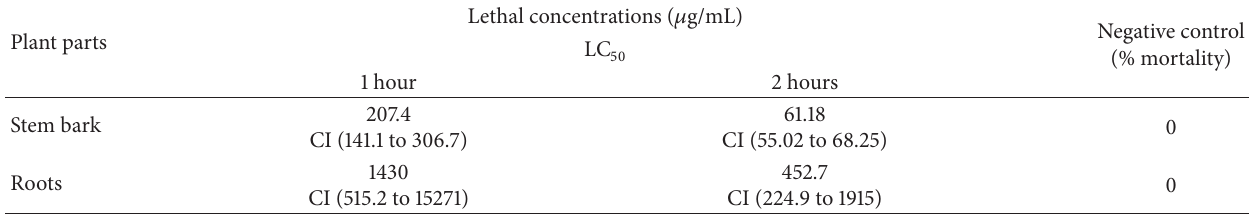
Table 1: In vitro cercariacidal effect of ethanol extract of Rauwolfia vomitoria stem bark and root on S. mansoni cercariae.